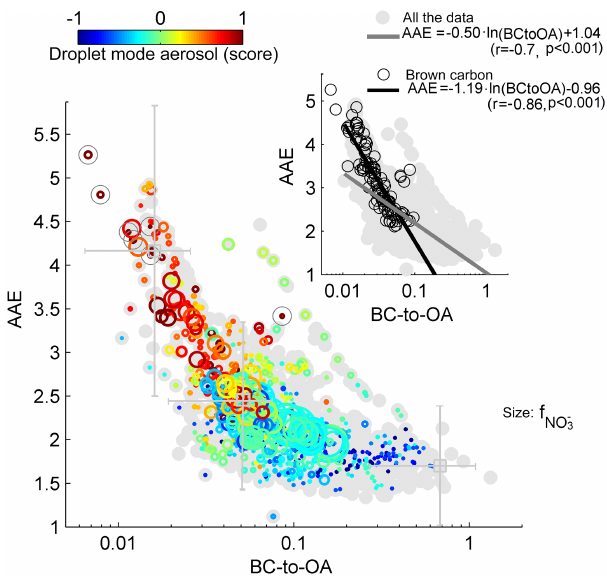
Figure 3. Dependence of AAE on BC-to-OA ratios. Grey markers show the longest available time series for AAE at 467–660nm and BC-to-OA ratios, while marker color and size indicate data points for which the droplet-mode aerosol scores and f NO were avail- 3 able (Sect. 3). Median values (grey squares) and relevant data un- certainty are indicated at the upper, mean, and lower AAE bins. Data indicated by dark grey “o” show case study values illustrated in Fig. 4. Inner panel: best fit lines with relevant equation and Pearson’s correlation coefficients ( r,p ) to all the data measured (grey line) and droplet-mode BrC data (black line) (as indicated by droplet-mode aerosol score >